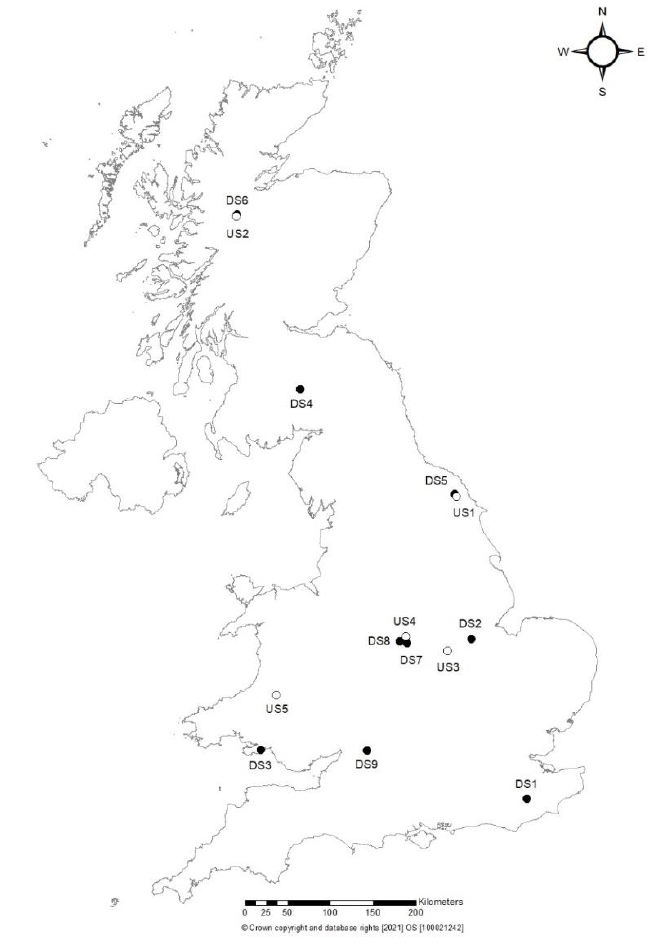
Figure 1. Map of Britain showing the sites where samples were collected for this study. Table 1. Description of site and locations sampled in the study with nearest hosts and health status, and the Phytophthora / Nothophytophthora species identified by using Internal Transcribed Spacer (ITS) and cytochrome c oxidase I (COI) regions or by isolation from soil.